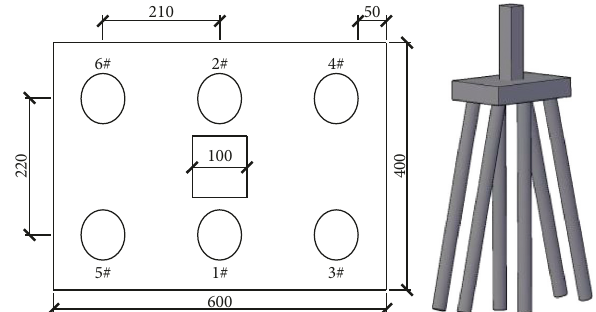
Figure 1: Layout of the inclined straight alternating pile group.